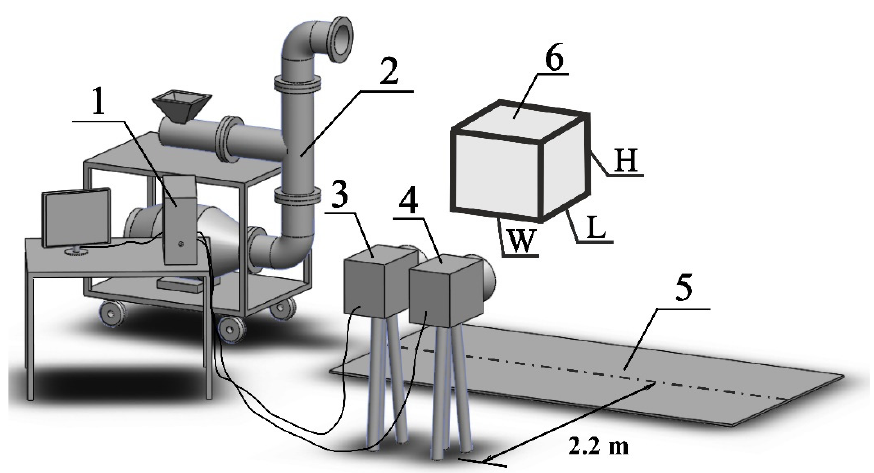
Figure 2. Experimental setup: 1—data recording system, 2—generator of burning firebrands, 3—IR camera, 4—video camera; 5—test site; 6—detection volume.